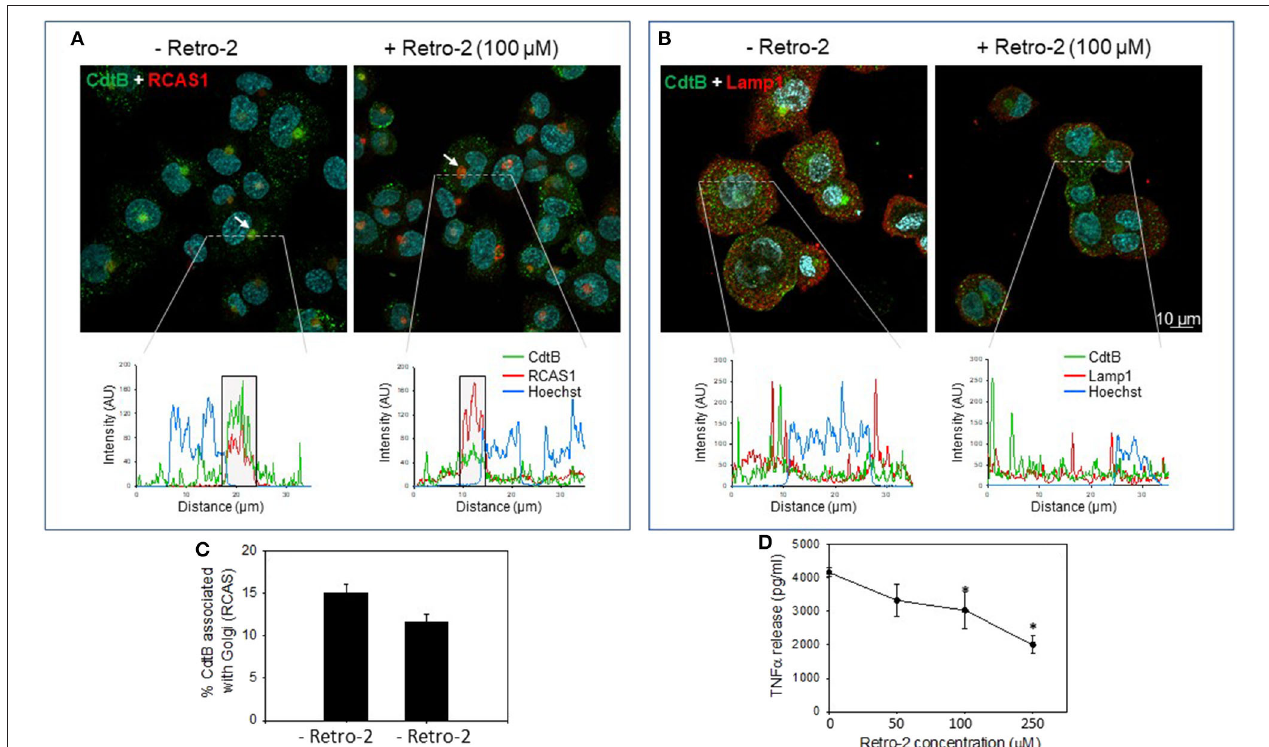
FIGURE 3 | Retro-2 blocks retrograde transport of CdtB to Golgi. Confocal images showing maximum intensity projections (from 6 µ n Z stack) of differentiated THP-1 WT cells pre-treated for 1h with medium alone (left) or with Retro-2 (100 µ M, right); both samples then received Cdt (1 µ g/ml). After 1h, cells were stained for CdtB and RCAS1 or Lamp1. Nuclei stained with Hoechst are pseudo-colored in cyan. (A) Maximum intensity projections for CdtB (green) and RCAS1 (red). Bottom graphs represent intensity profiles for CdtB (green), RCAS1 (red), and Hoechst nuclear stain (blue) across dotted lines depicted. Boxed regions correspond to RCAS1 and CdtB positive structures (marked by white arrows in the top panel). (B) Maximum intensity projections for CdtB (green) and Lamp1 (red). Bottom graphs represent intensity profiles for CdtB (green), Lamp1 (red), and nuclear stain (blue) across dotted lines depicted. AU, arbitrary units. All images are representative of four independent experiments (3–4 fields per experiment). (C) Shows the results of the analysis for the percent of CdtB associated with Golgi with and without Retro-2. Data are plotted as mean ± SEM. (D) THP-1 WT macrophages were treated with Retro-2 and Cdt as described above; 5h later supernatants were analyzed by ELISA for TNF α . Results are the average (pg/ml) TNF α ± SEM of three experiments; *indicates statistical significance ( p < 0.05).